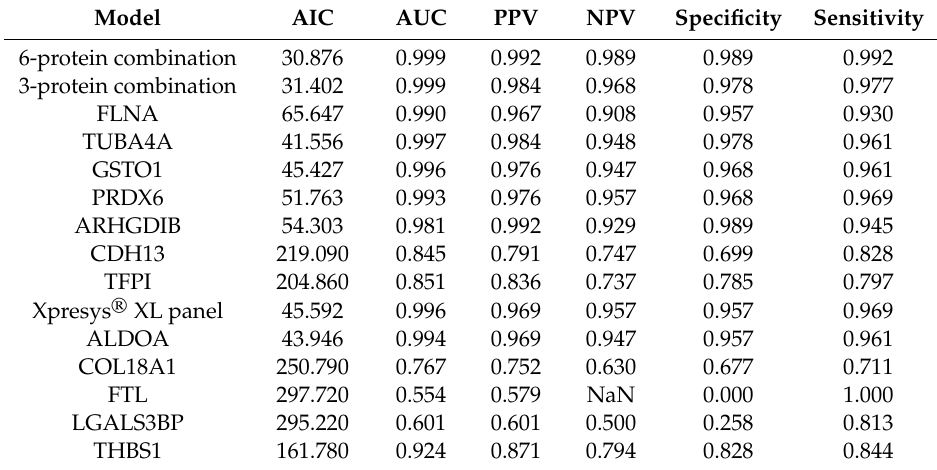
Table 1. Performance of the logistic regression models in tumor